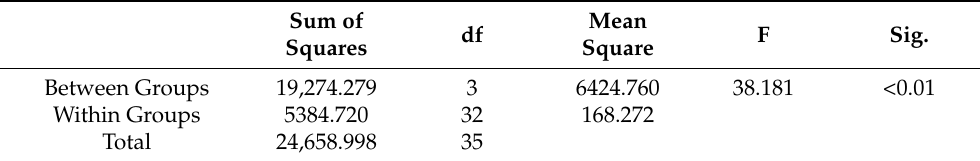
Table 3. One-way